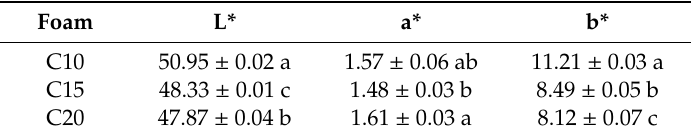
Table 3. Color parameters of foams developed from potato